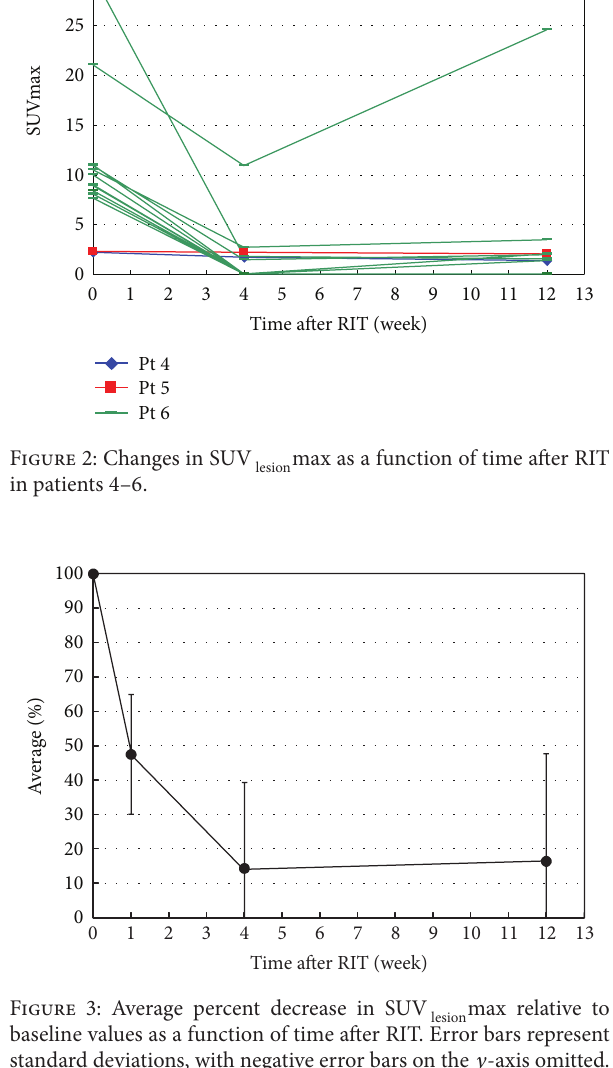
max relative to lesion